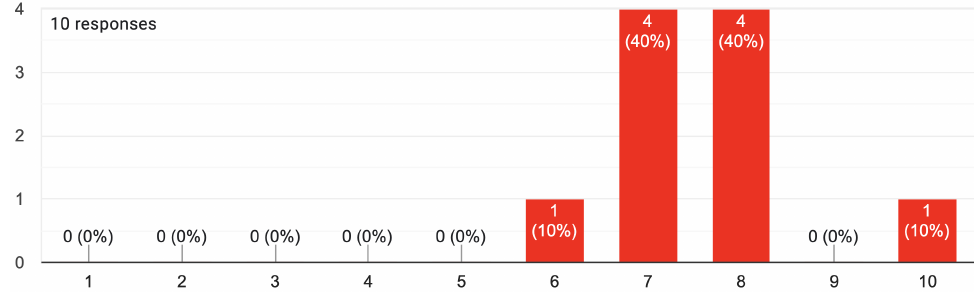
Figure 9. Feedback collected from students: on a scale of 1–10 with 1 being not engaging at all and 10 being extremely engaging, how engaging do you consider the theoretical